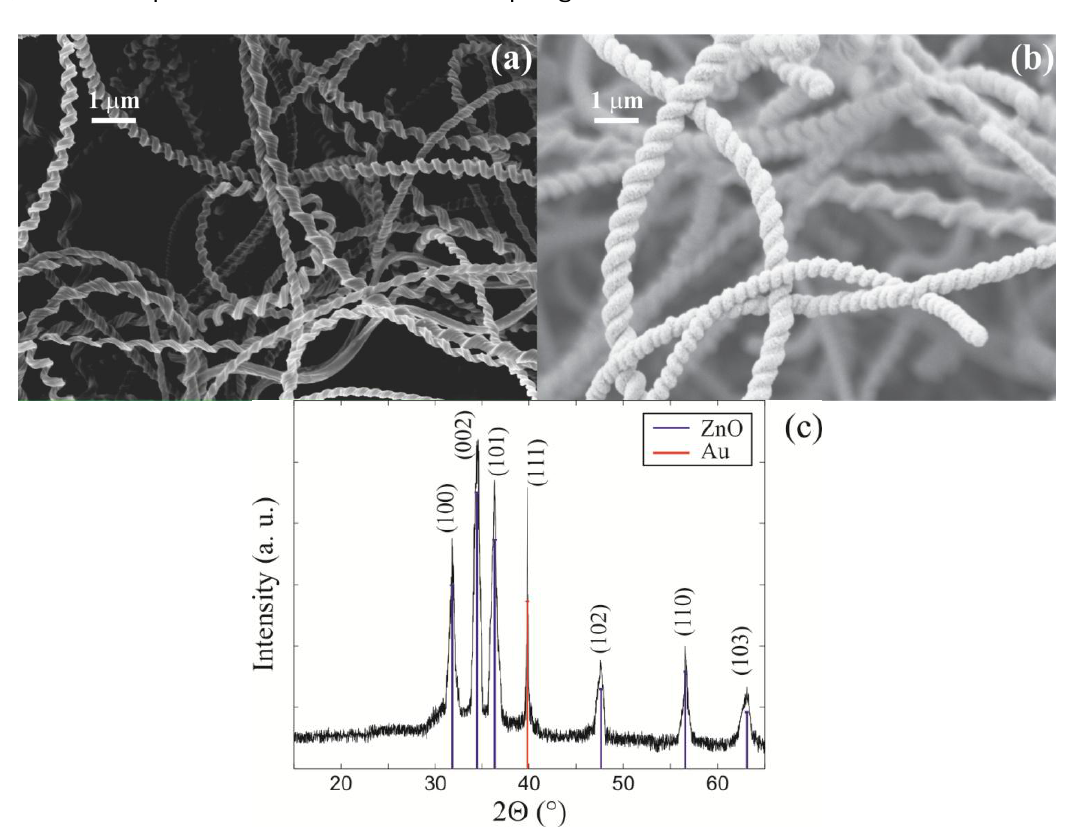
Figure 1. SEM micrographs of ( a ) a silica nanospring mat; ( b ) of ZnO coated nanosprings; ( c ) An XRD spectrum of ZnO coated